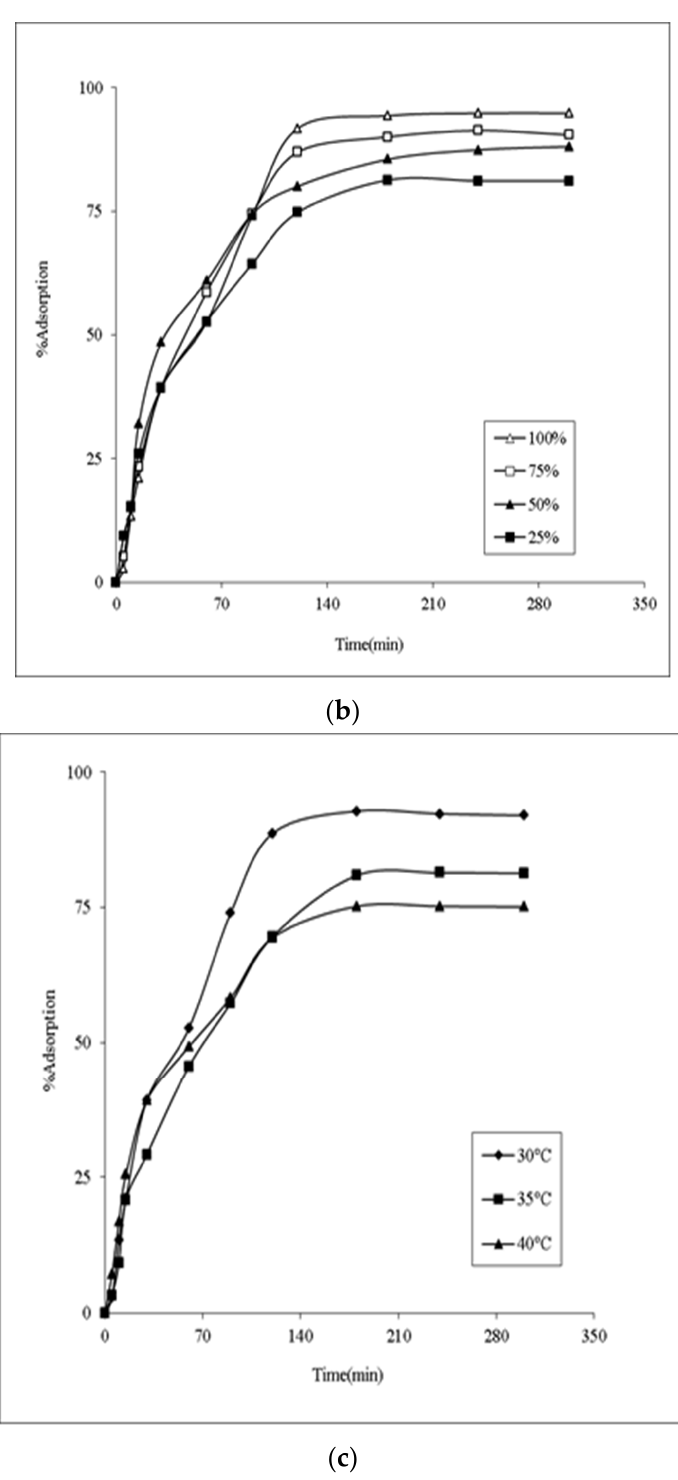
Figure 1. The effect of process parameters on adsorption of urea. ( a ) Fecal ash loading (initial urine concentration—13.5 g.L − 1 , temperature—30 ◦ C); ( b ) initial urine concentration (fecal ash loading—1.0 g, temperature—30 ◦ C); ( c ) temperature (fecal ash loading—1.0 g, initial urine concentration—13.5 g.L − 1